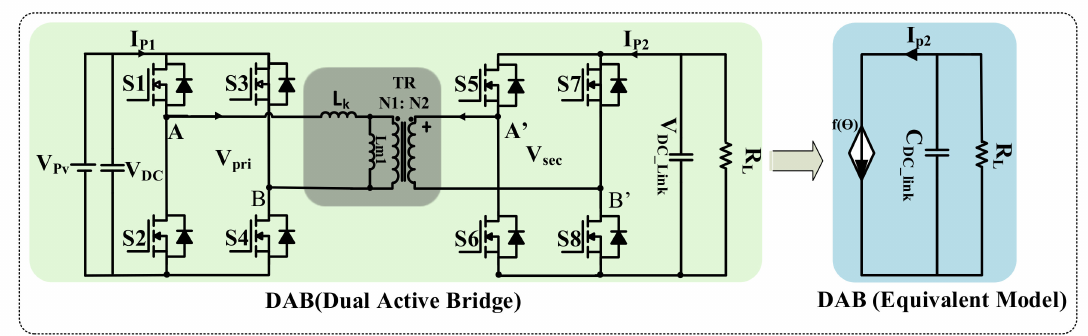
Figure 5. Simplified small signal average model of a DAB (Dual Active Bridge)